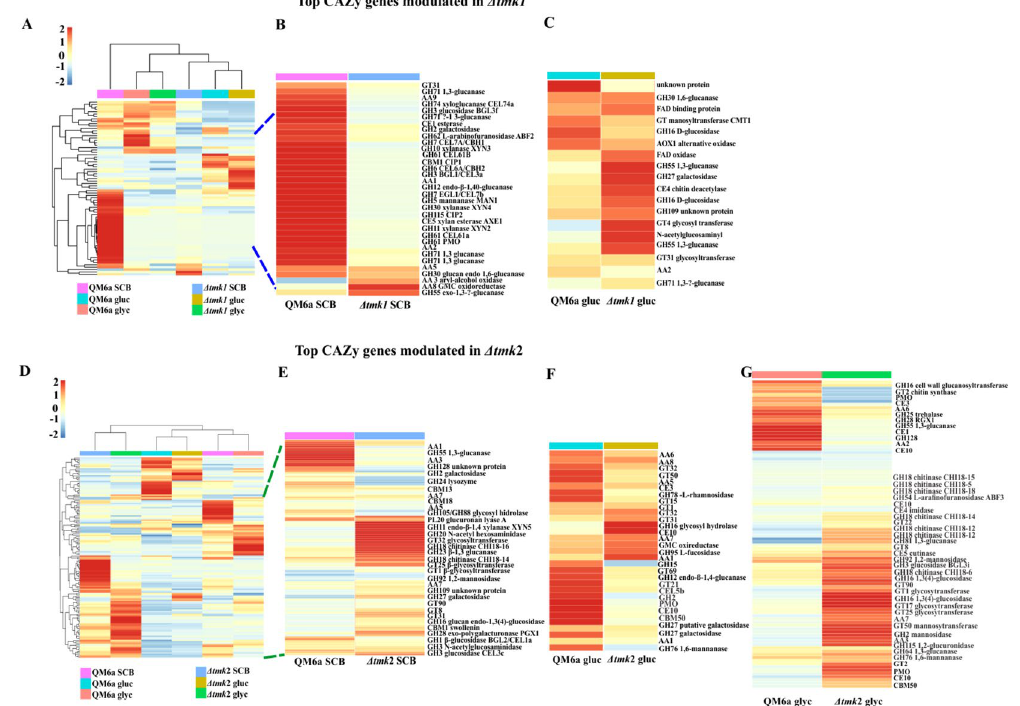
Figure 4. Cellulase gene expression profile of T. reesei QM6a, Δ tmk1 , and Δ tmk2 strains during growth in glucose (gluc), glycerol (glyc), and sugarcane bagasse (SCB). ( A ) Heatmap of differentially expressed CAZy genes in the Δ tmk1 and QM6a strains showing all the conditions of this study. ( B ) Heatmap of differentially expressed CAZys in Δ tmk1 and QM6a strains grown in sugarcane bagasse. ( C ) Heatmap of differentially expressed CAZys of Δ tmk1 and QM6a strains grown in glucose. ( D ) Heatmap of differentially CAZy genes in the Δ tmk2 and QM6a strains showing all the conditions of this study. ( E ) Heatmap of differentially expressed CAZys in Δ tmk2 and QM6a strains grown in sugarcane bagasse. ( F ) Heatmap of differentially expressed CAZys from Δ tmk2 and QM6a strains grown in glucose. ( G ) Heatmap of differentially expressed CAZys from Δ tmk2 and QM6a strains grown in glycerol. The hierarchical clustering was performed using the R pheatmap package. Complete linkage method and Euclidean distance of row centered and scaled TPM values were used for hierarchical clustering of the differentially expressed genes in all analyzed